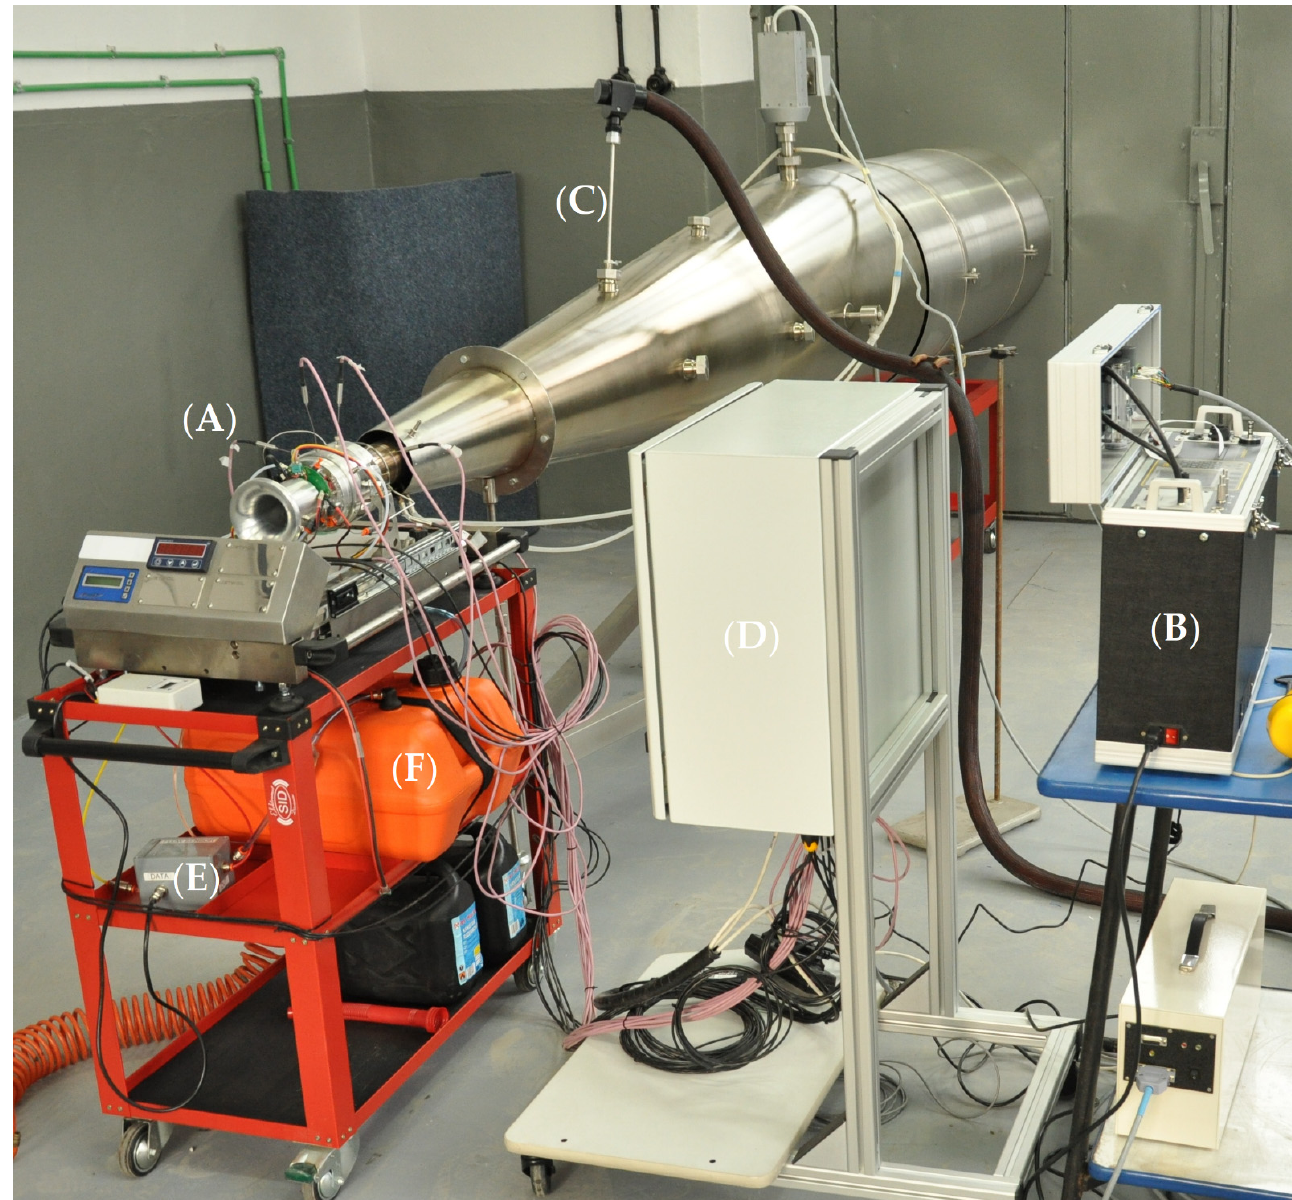
Figure 1. MiniJETRig: ( A ) miniature turbojet engine, ( B ) exhaust analyzer, ( C ) exhaust gas sample probe, ( D ) block of measurement cards, ( E ) flow meter, ( F ) fuel tank.